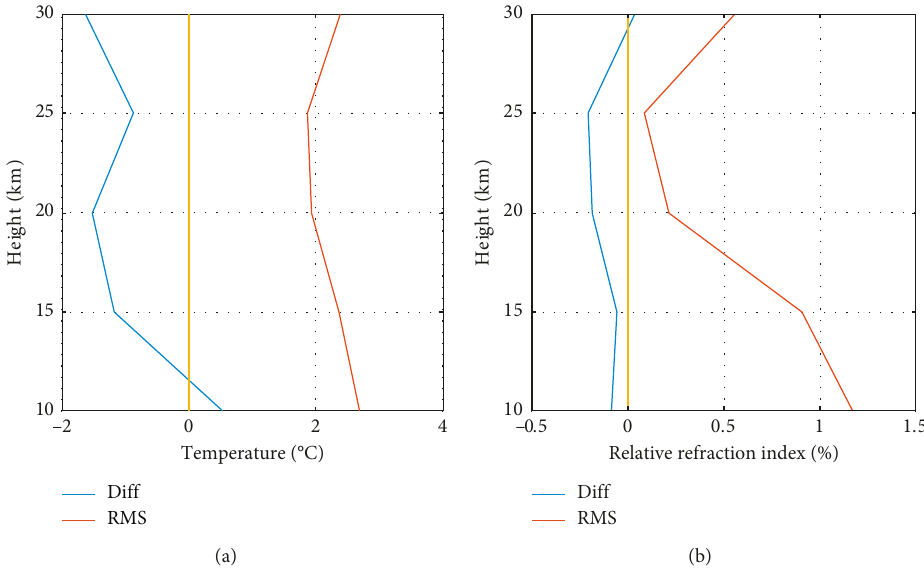
Figure 10: Statistics of the temperature profiles and the relative refraction index obtained from FY-3C occultation data and radiosonde data.